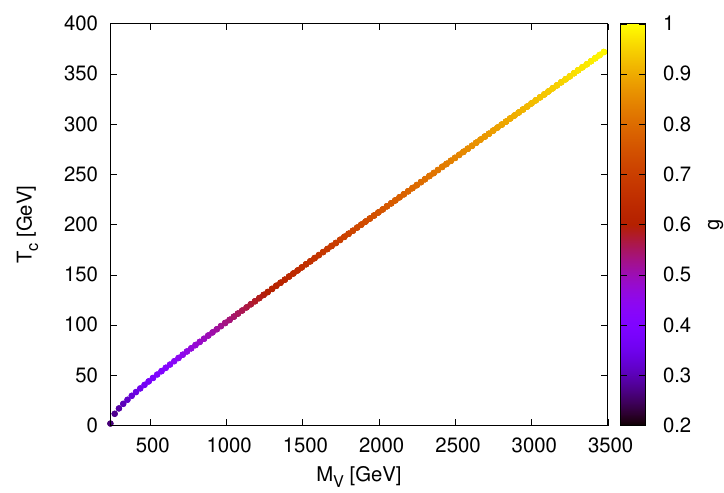
Figure 6 . Critical temperature versus mass of vector DM for the parametrs which satisfy DM relic density constraint.